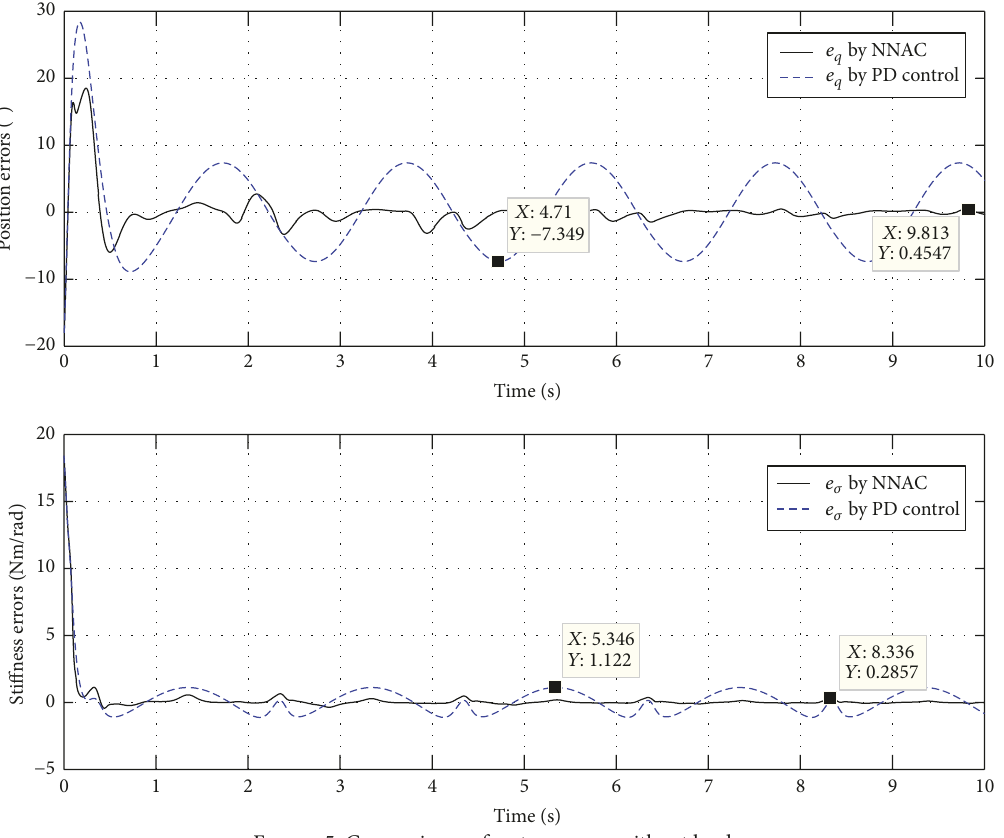
Figure 5: Comparisons of system errors without load.